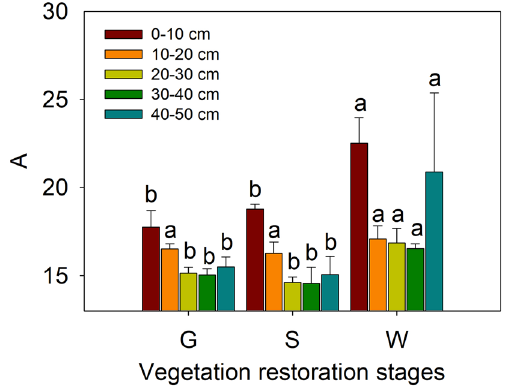
Figure 4. Soil water characteristic parameter A in the different soil layers at different vegetation restoration stages (see Table 1). The values are in the form of means ± SEs, and the sample size (n) is 5. The different lowercase letters above the bars indicate significant differences within a soil layer among the different vegetation restoration stages ( P < 0.05).